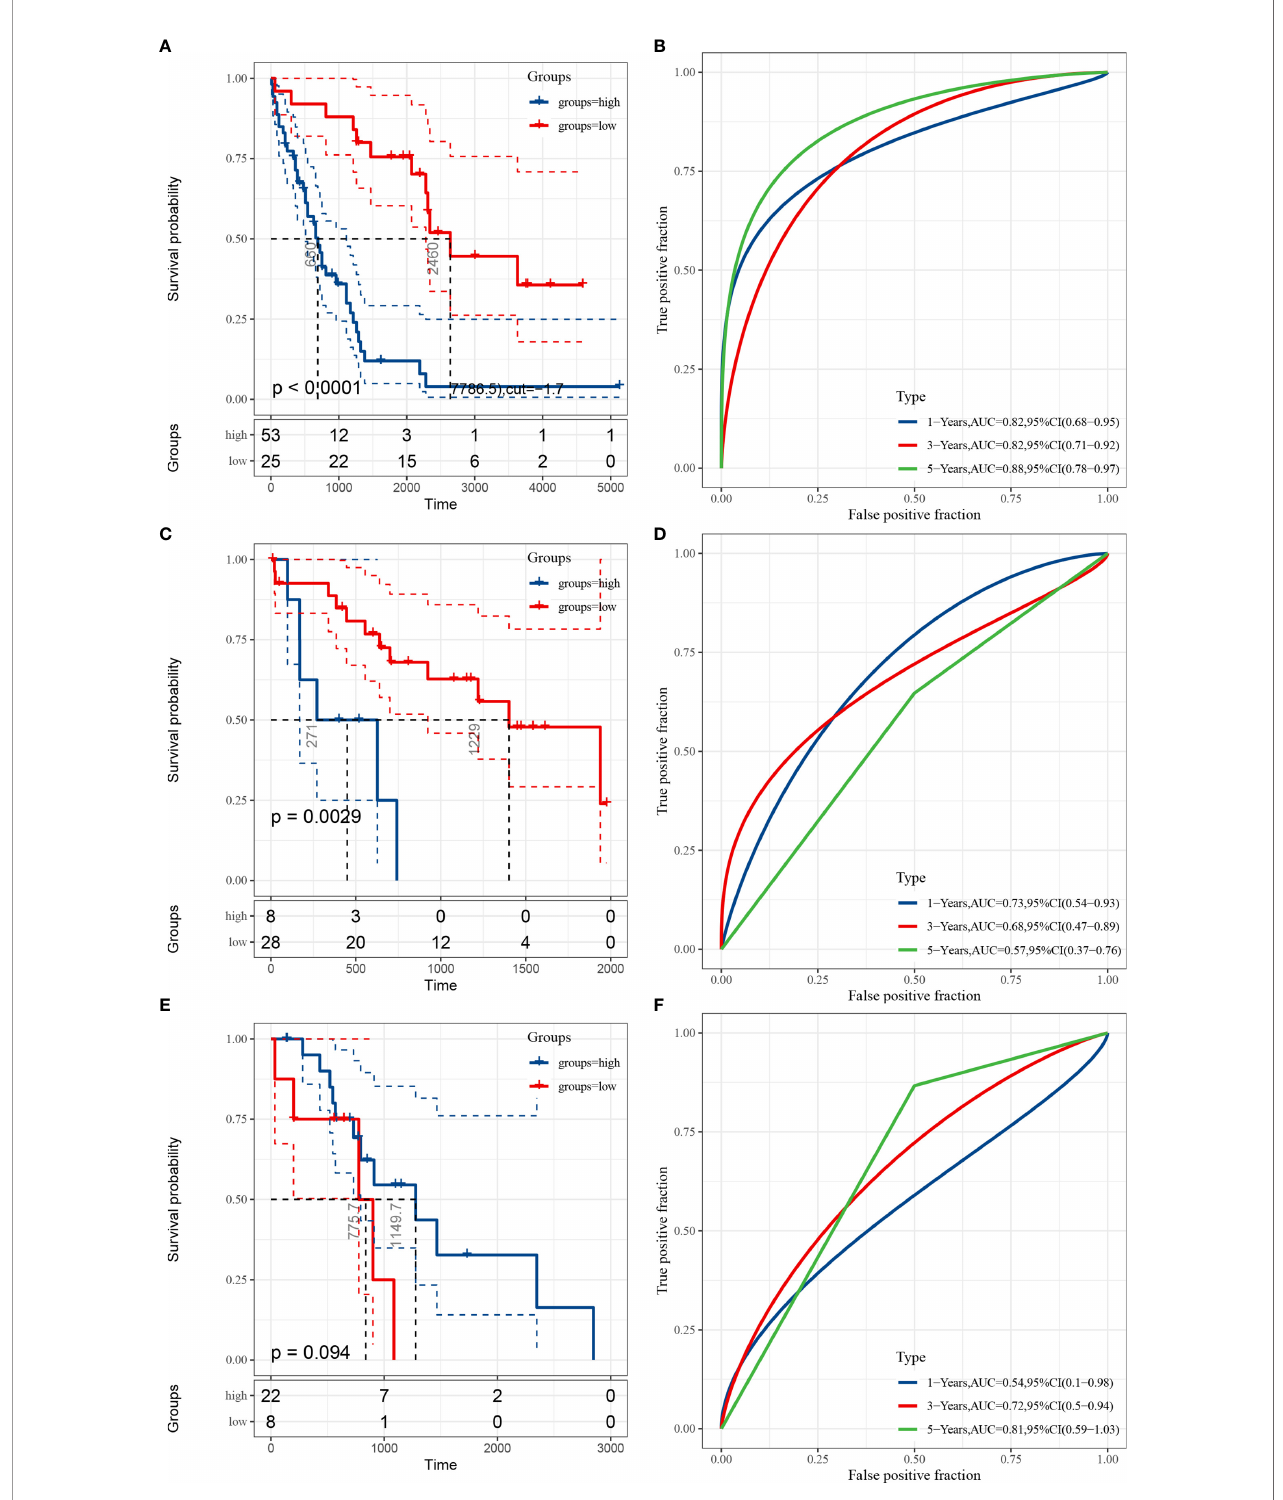
FIGURE 4 | Evaluation and validation of the prognostic performance of the Fer-score in three independent cohorts. (A, C, E) KM survival curves according to the Fer-score in the E-MTAB-6389, TCGA-CHOL, and GSE107943 data sets. (B, D, F) ROC curves at 1, 3, and 5 years according to the Fer-score in the E-MTAB- 6389, TCGA-CHOL, and GSE107943 data